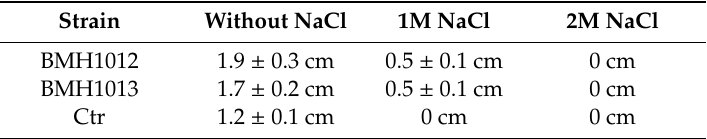
Table 2. Fungal colony growth in the absence or presence of NaCl at different concentrations. The growth was measured as the diameter of the colonies. Table2. FungalcolonygrowthintheabsenceorpresenceofNaClatdi ff erentconcentrations. Thegrowth was measured as the diameter of the